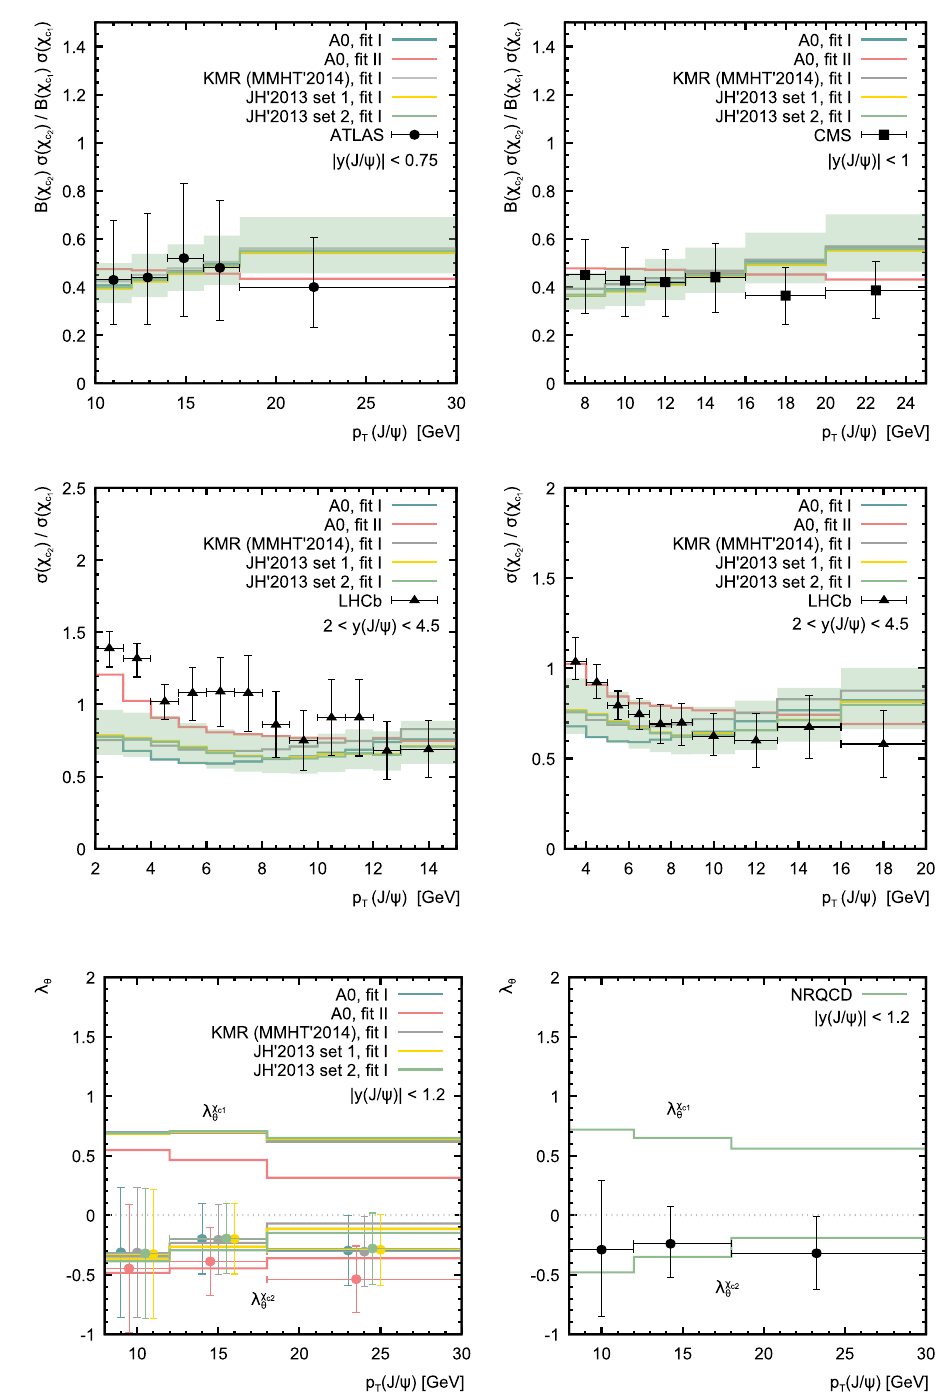
χ c 2 Fig. 5 The λ θ values determined according to correlations (5)–(7) when the λ χ c 1 θ is fixed to our predictions (left panel) or NRQCD ones (right panel). The NRQCD predictions are taken from CMS paper